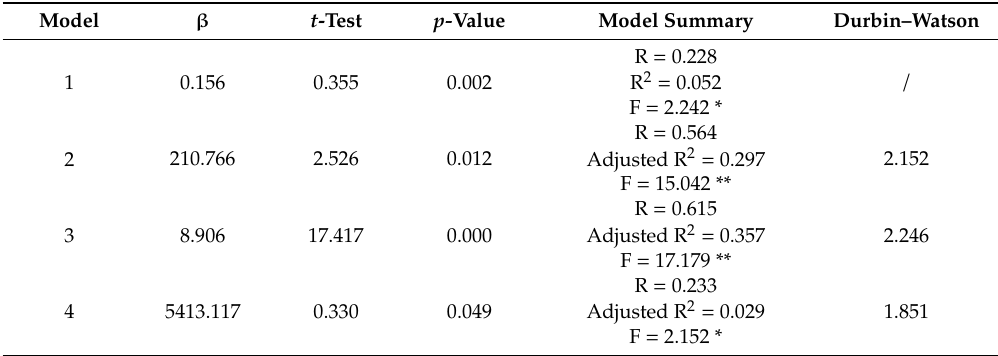
Table 2. Values of statistical and econometric